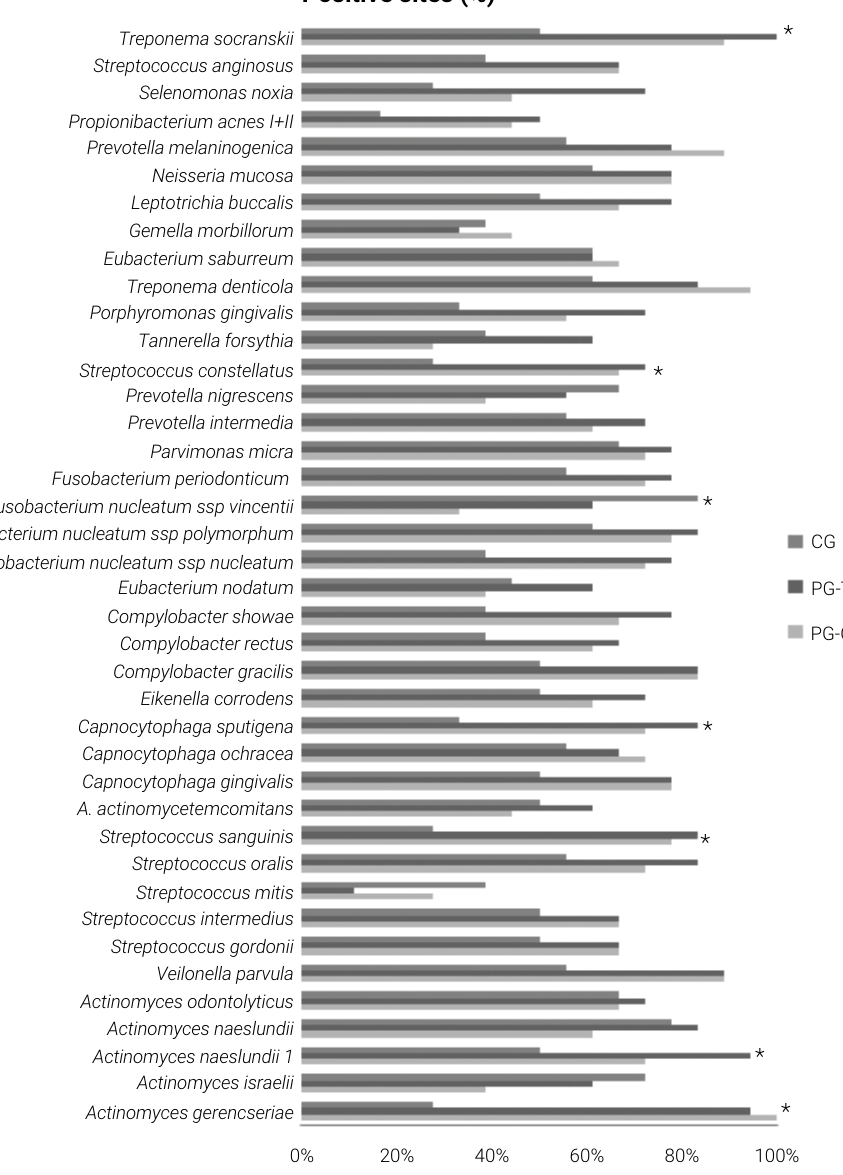
Figure 2. Proportion (mean % and DP) of bacterial complexes in different groups (Healthy – Control, CG; Periodontitis – Test, PG-T and Periodontitis – Control, PG-C). Statistically significant differences among groups were evaluated by Kruskal-Wallis followed by Mann-Whitney Test